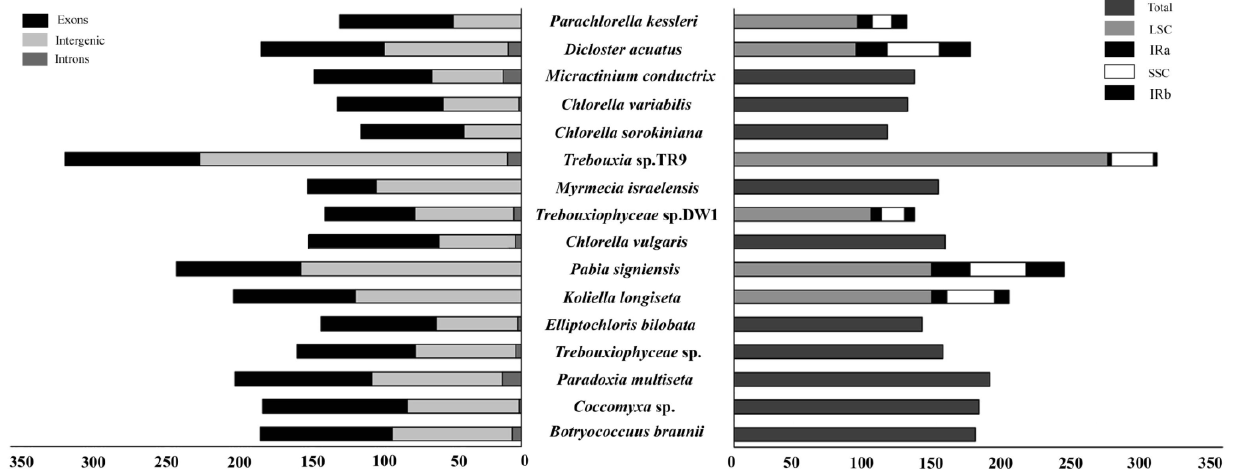
Figure 6. Total lengths of different regions of the cpDNAs in Trebouxiophyceae. The proportions of exons, introns and intergenic sequences in the chloroplast genome are shown on the left, and the proportions of IRS, LSC and SSC regions in the chloroplast genome are shown on the right.